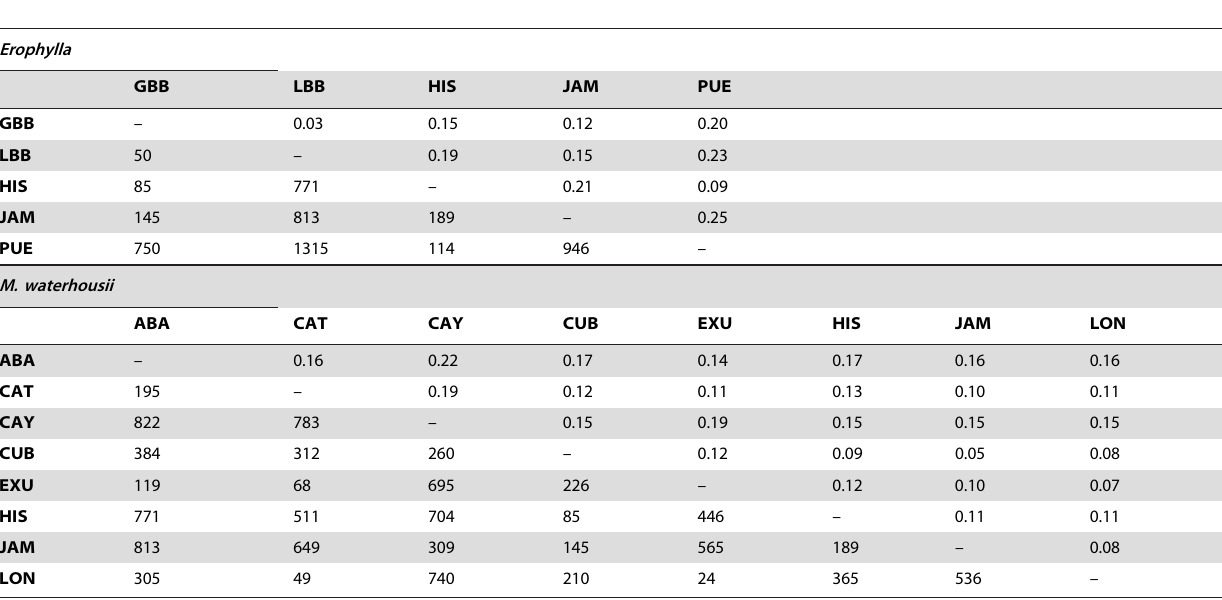
Table 2. F ST (above diagonal) and Euclidean distance in km (below diagonal) for Erophylla among groups and for M. waterhousii among islands.